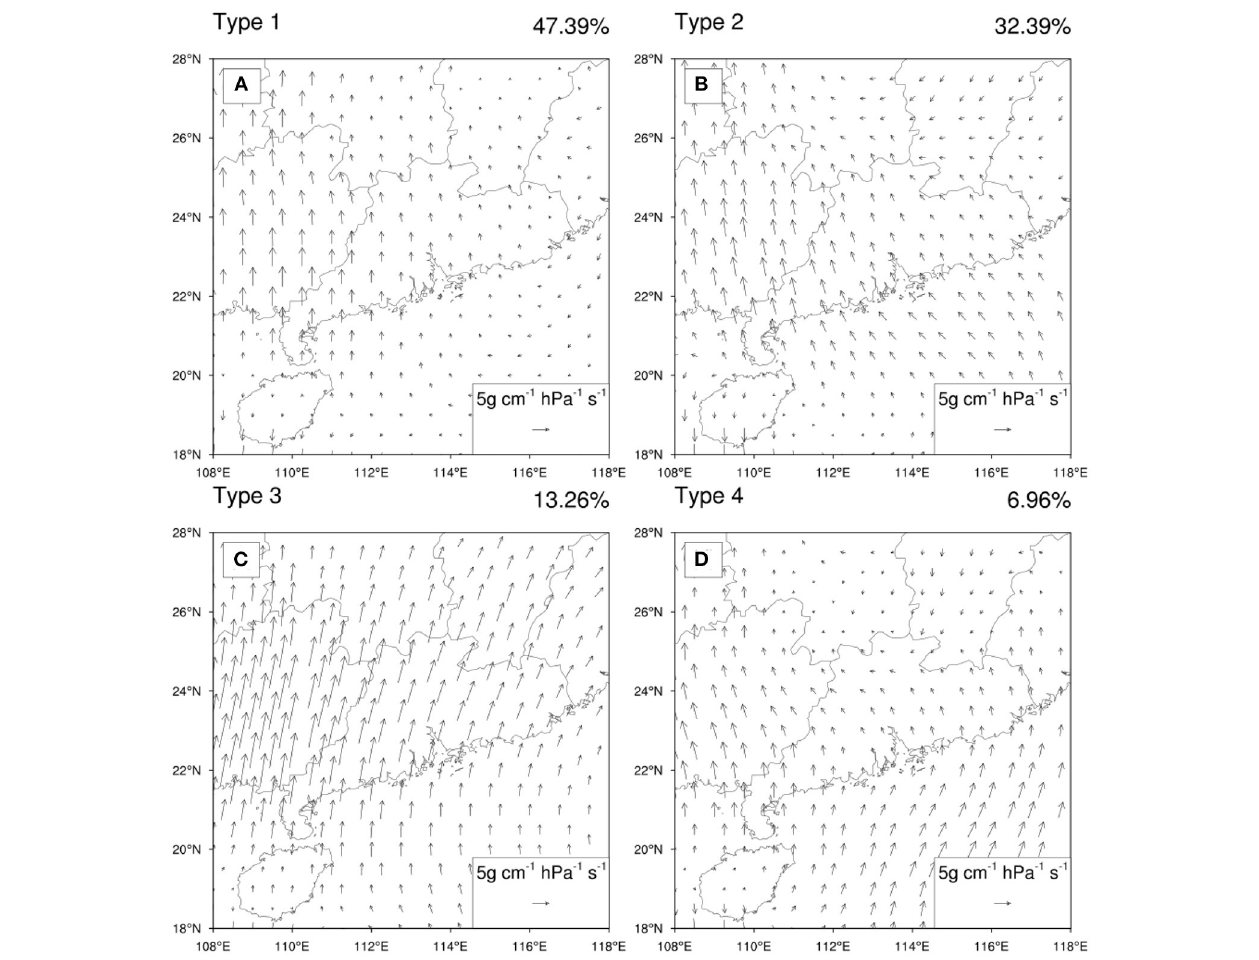
FIGURE 6 | The anomalous water vapor flux at 850hPa for four weather types relative to summer mean values: (A) Type 1, (B) Type 2, (C) Type 3, and (D) Type